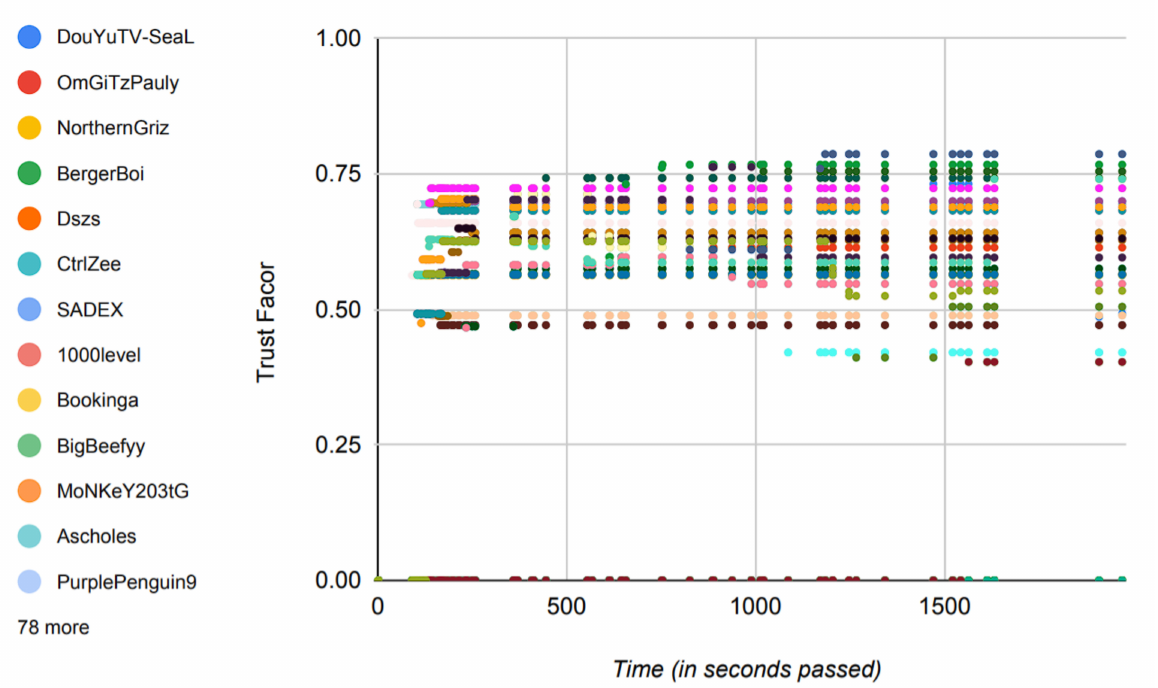
Figure 15. Variations in trust factors of players with time from the